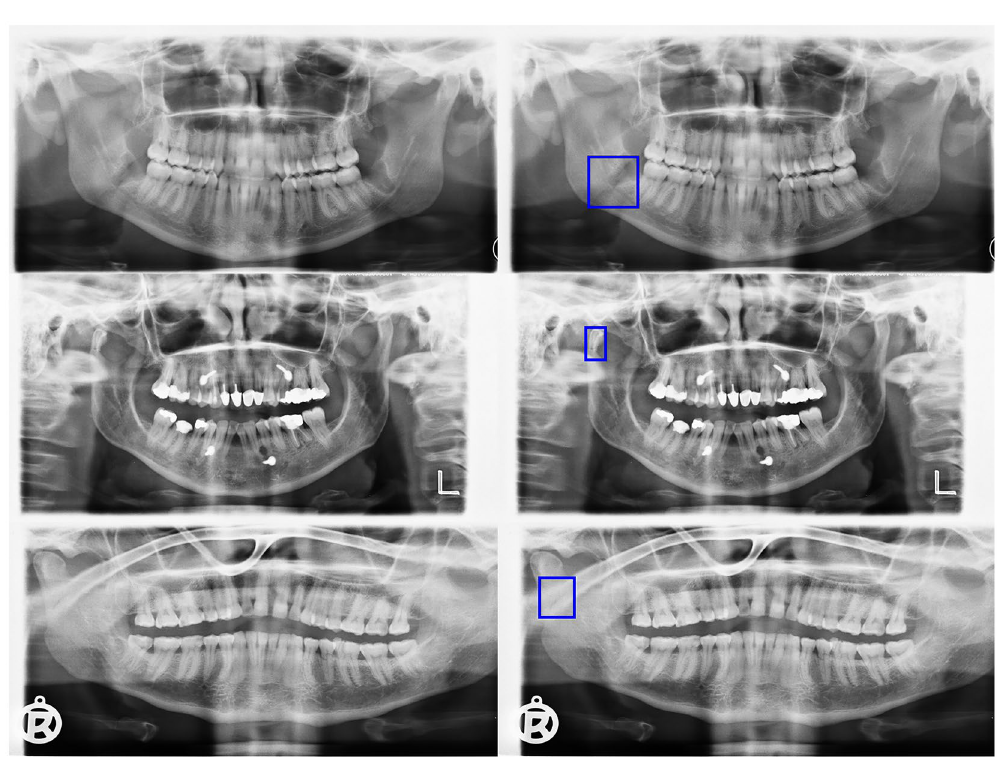
Figure 4. False positive predictions. The model predicted bounding boxes in areas without